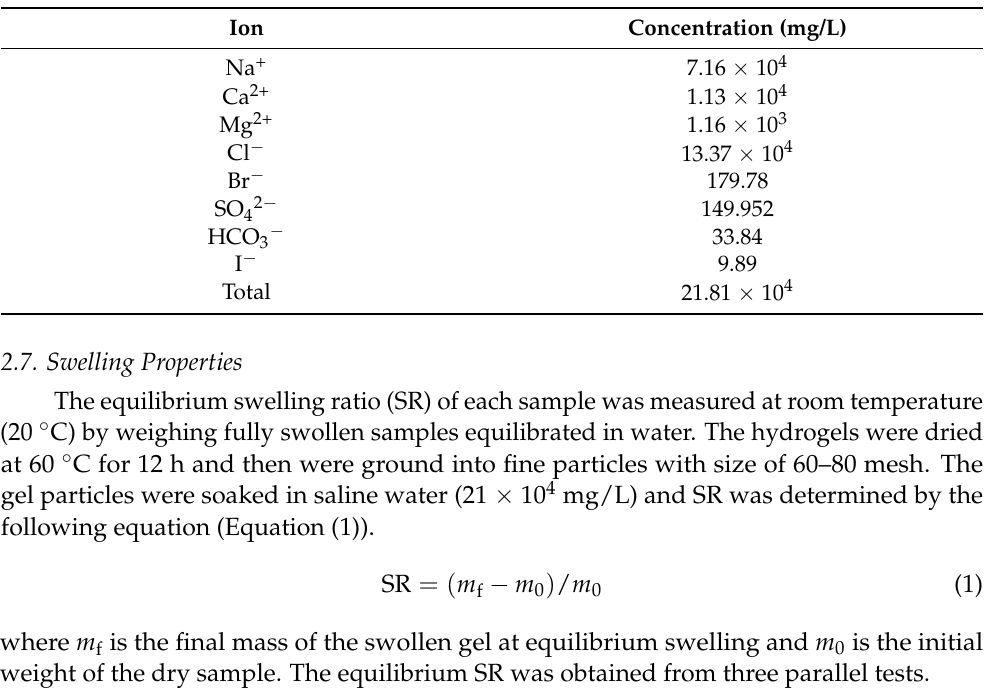
Table 2. Ion concentration of salinity water.